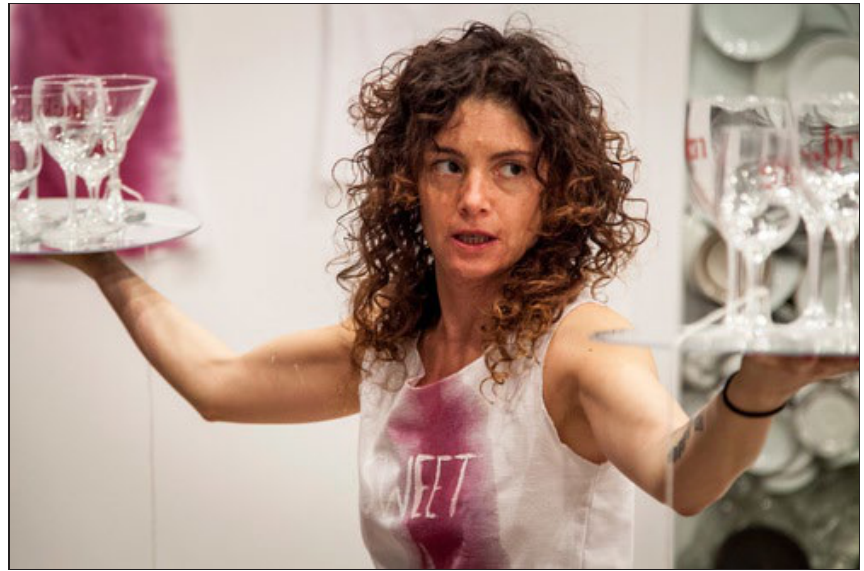
Figure 5: Alejandra Herrera Silva. Testing the Waters 2016. Photo courtesy of Michael